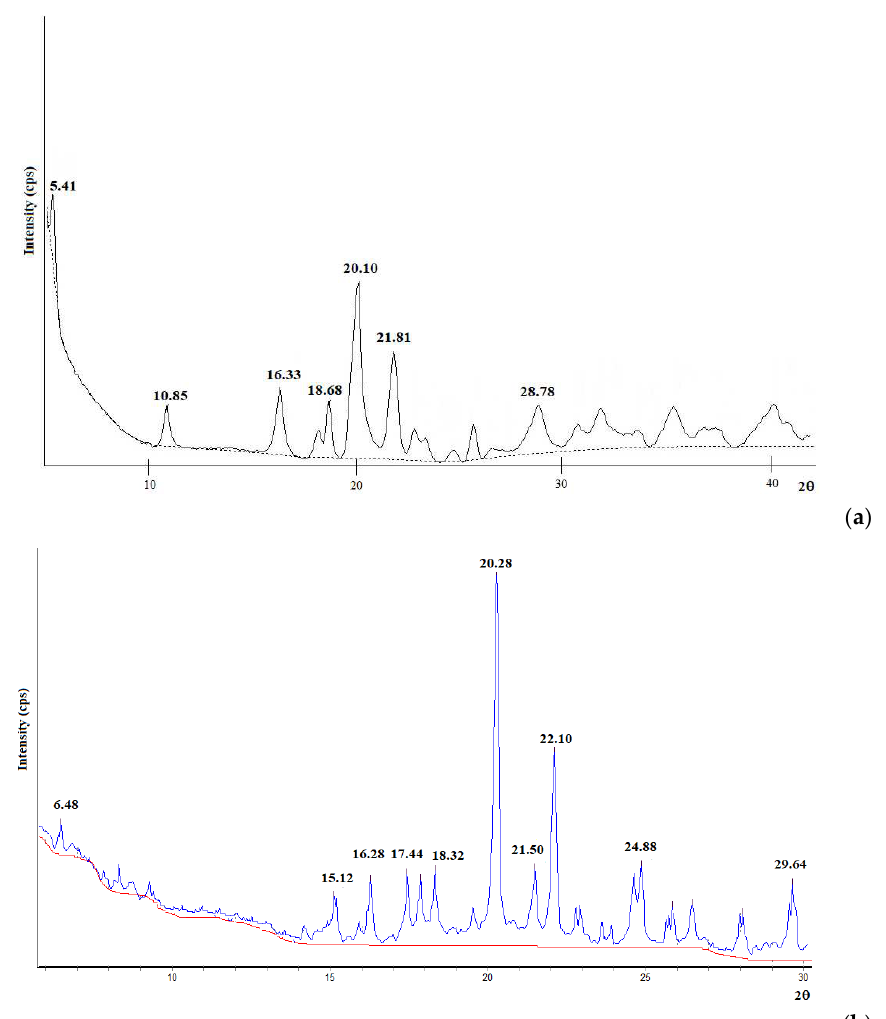
Figure 1. XRD pattern of composite [Cu( S -Ala) 2 ]–[Cu( S -Phe) 2 ] ( 1 ) ( a ) and composite [Zn( S -Ala) 2 (H 2 O)]–[Zn( S -Phe) 2 (H 2 O)] ( 2 ) ( b ).